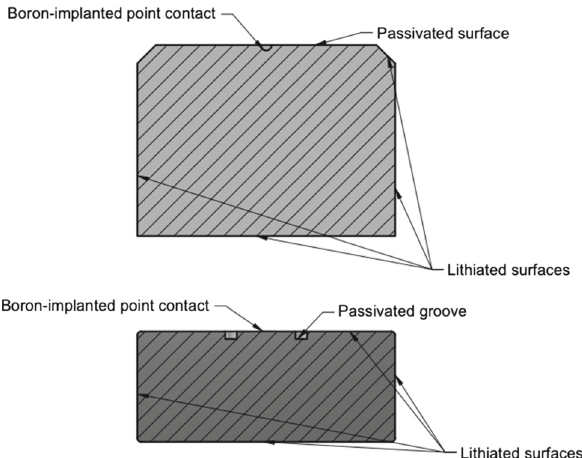
Fig. 3 Diagramsofthecommonly-usedPPCdetectorgeometriesfrom ORTEC (top) and Mirion